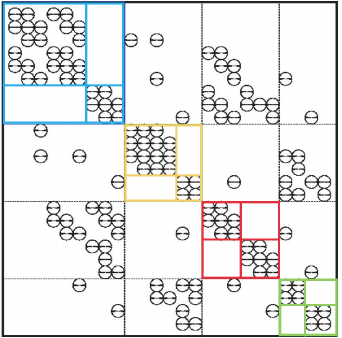
Figure 3. The coefficient matrix ordered by block multi-color